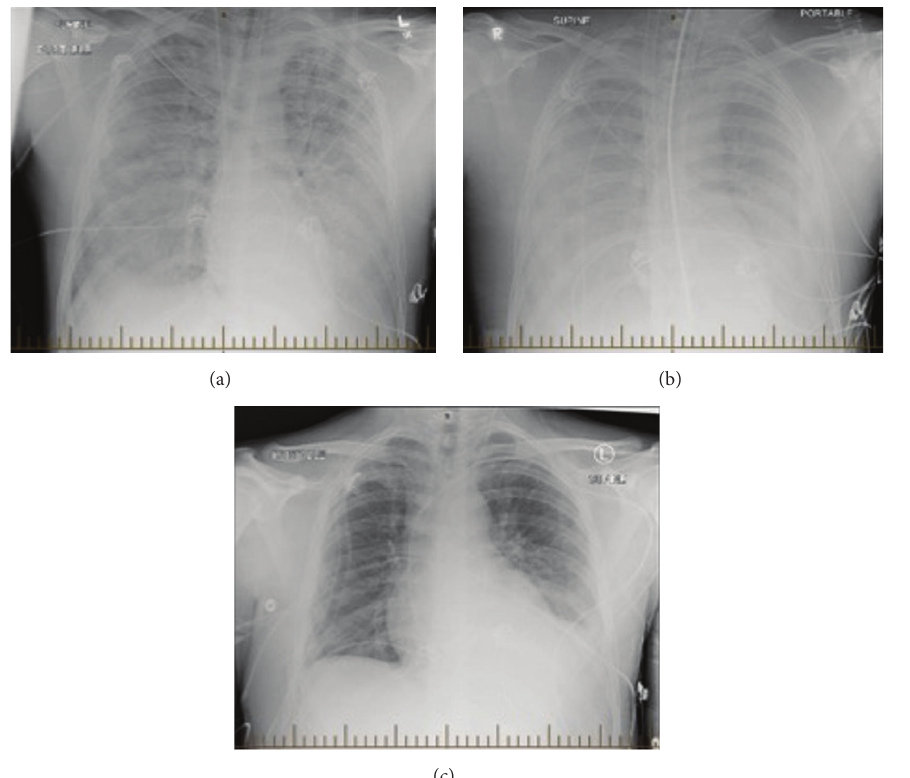
Figure 2: Radiographic progression of pulmonary disease in patient 1. (a) Chest radiograph on presentation; (b) chest radiograph on day two of admission following ECMO; (c) chest radiograph on day 10 of admission following